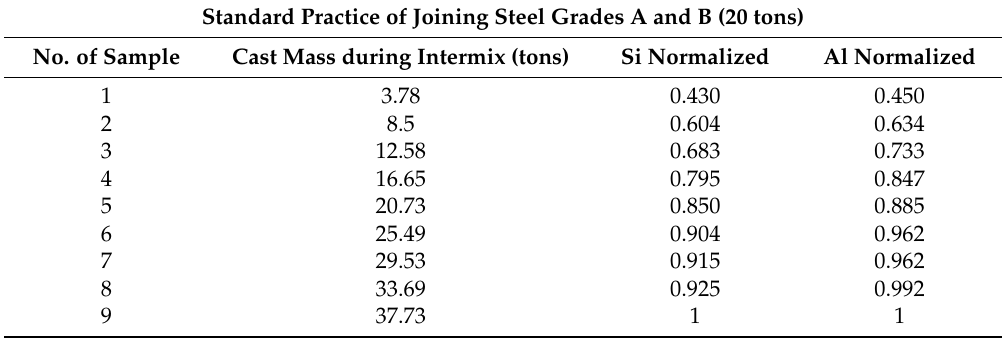
Table 3. Detailed course of the change in normalized composition for steel grades A and B (20 tons).